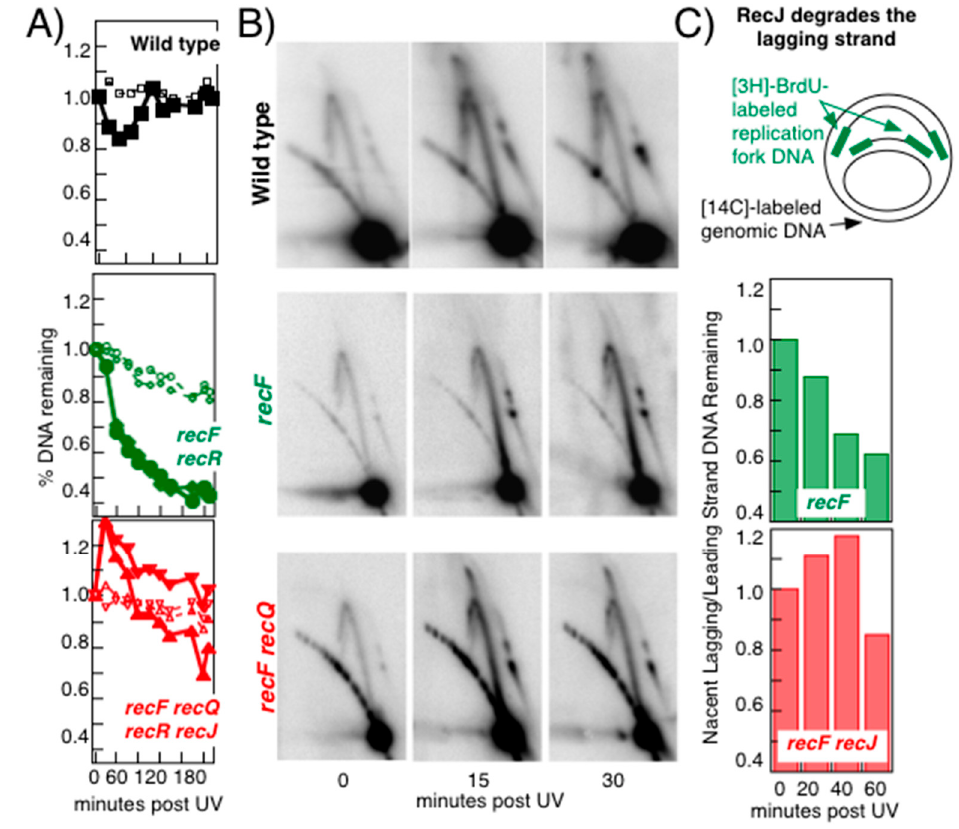
Figure 5. The RecQ helicase and RecJ nuclease degrade the nascent lagging strand of disrupted replication forks. ( A ) The nascent DNA degradation at disrupted replication forks does not occur